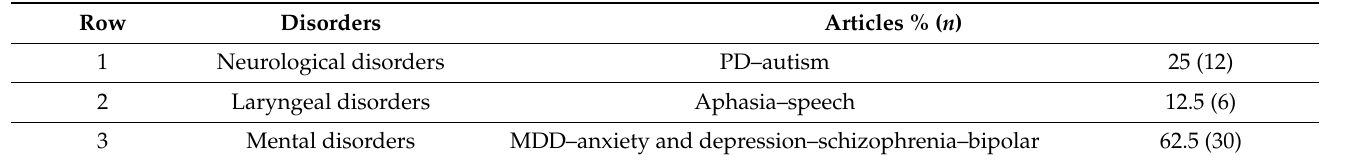
Table 2. Summary of systematic review